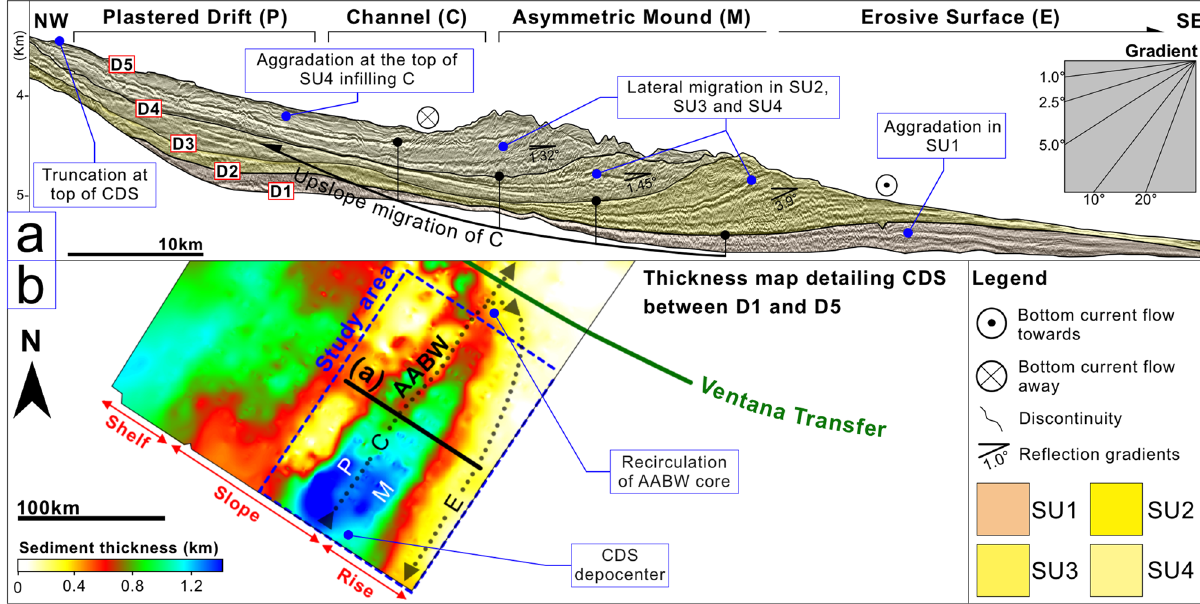
Figure 3. ( a ) Seismic profile detailing morphological features (P, C, M, and E), sedimentary stacking pattern, reflection gradients, and AABW cores; ( b ) map detailing the depocenter distribution and sedimentary thickness of the CDS. The figure was generated using Pixelmator Pro 2.1.3 Coral (https:// www. pixel mator. com/